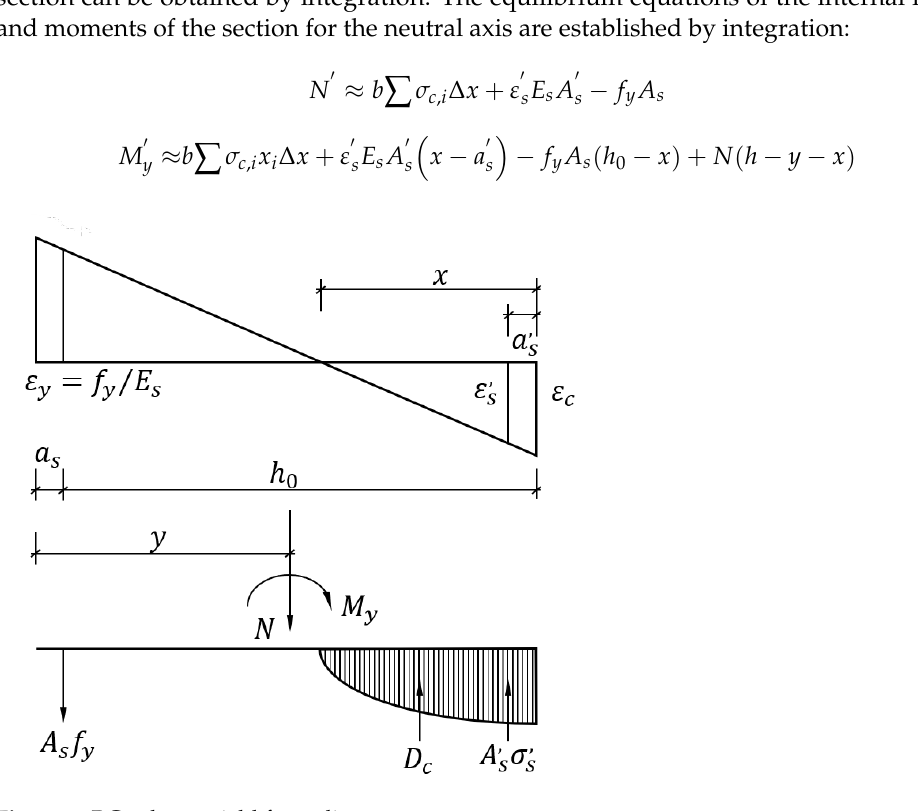
Figure 1. RC column yield force